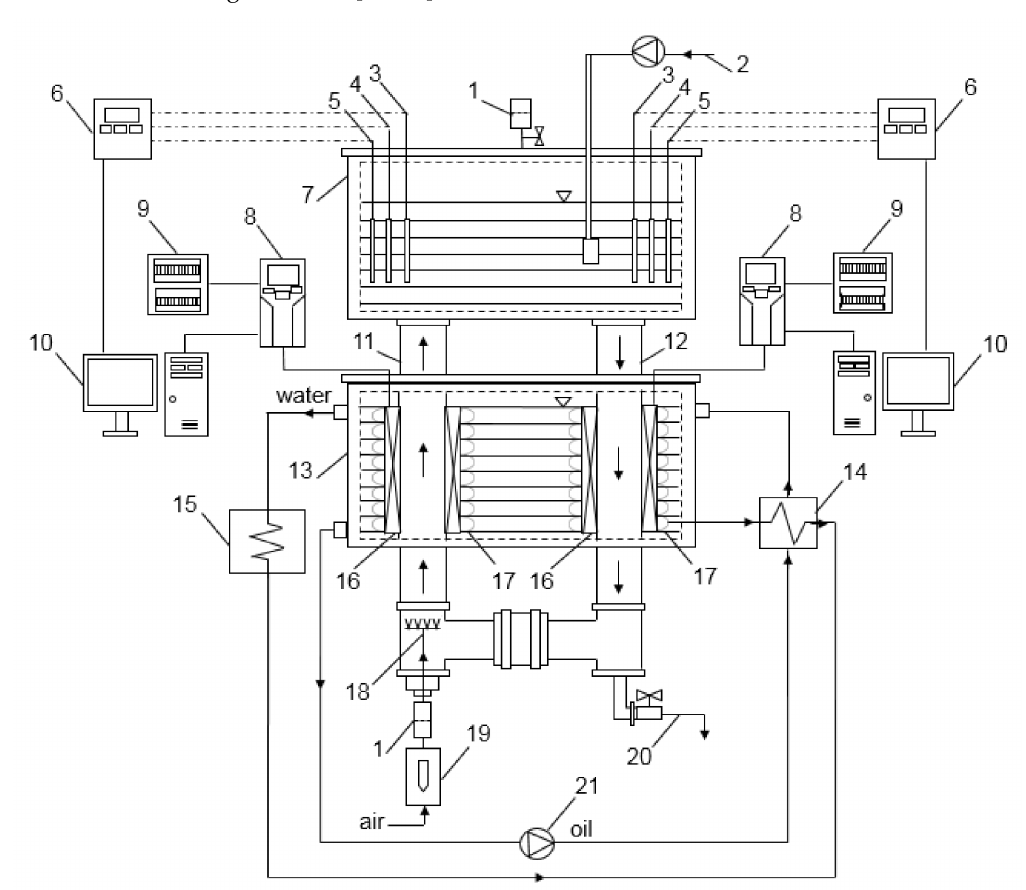
Figure 1. Experimental set-up: 1—filters; 2—fermentation medium dosing system; 3—temperature probes; 4—pH probes; 5— DO% probes; 6—measuring and control equipment; 7—upper chamber (separation zone); 8—inverters; 9—electrical boxes; 10—computers; 11—rising column; 12—falling column; 13—cooling liquid chamber; 14—heat exchanger; 15—thermostat; 16—magnetic field generators; 17—coils; 18—sparger; 19—rotameter; 20—inoculum removal system; 21—circulation